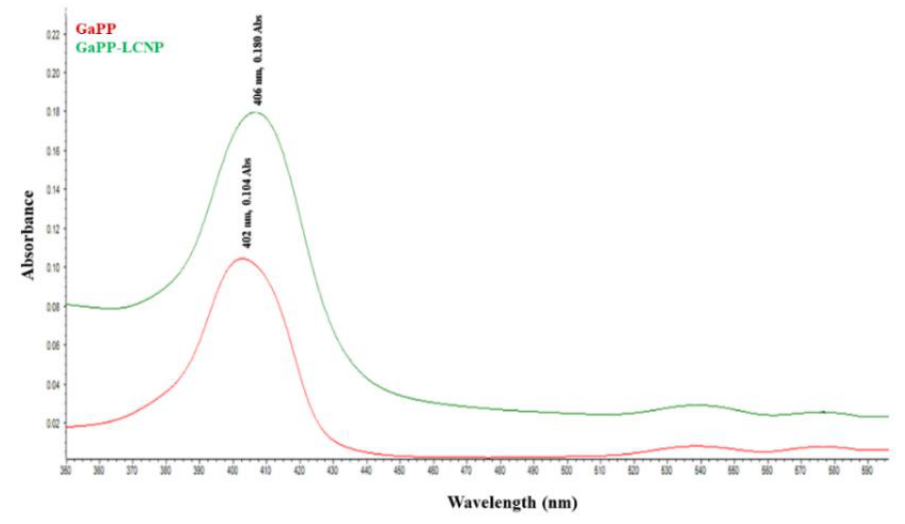
Table 1. Physicochemical characteristics of LCNP formulations.